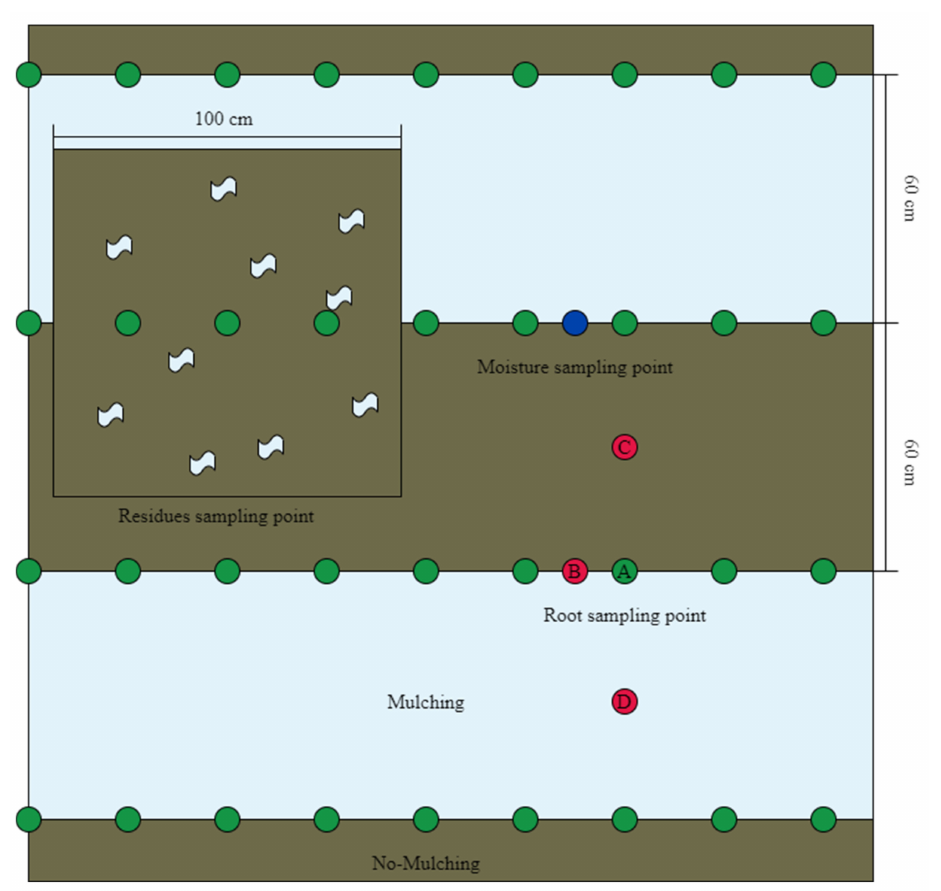
Figure 2. Schematic diagram of sampling point. Planting with 60 cm equal row spacing. A, planting spots; B, intra-plants’ spots; C and D, intra-rows’